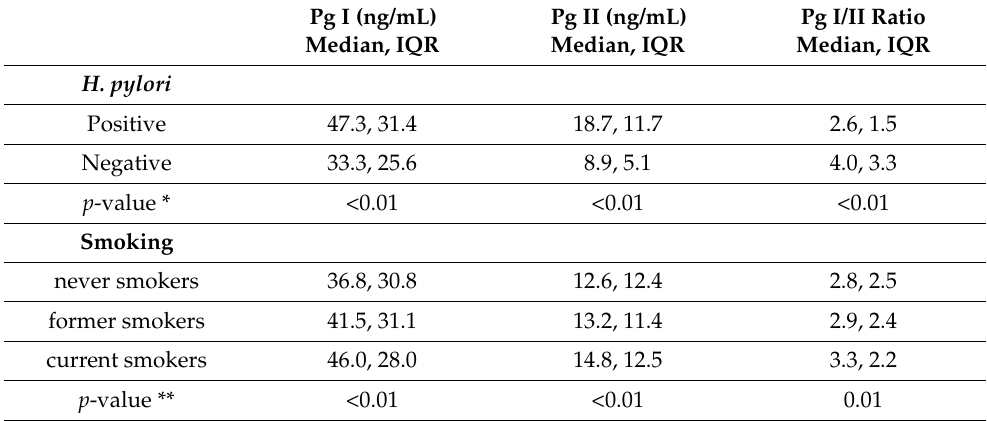
Table 2. Comparison of pepsinogen values by H. pylori presence and smoking status in the general study population.